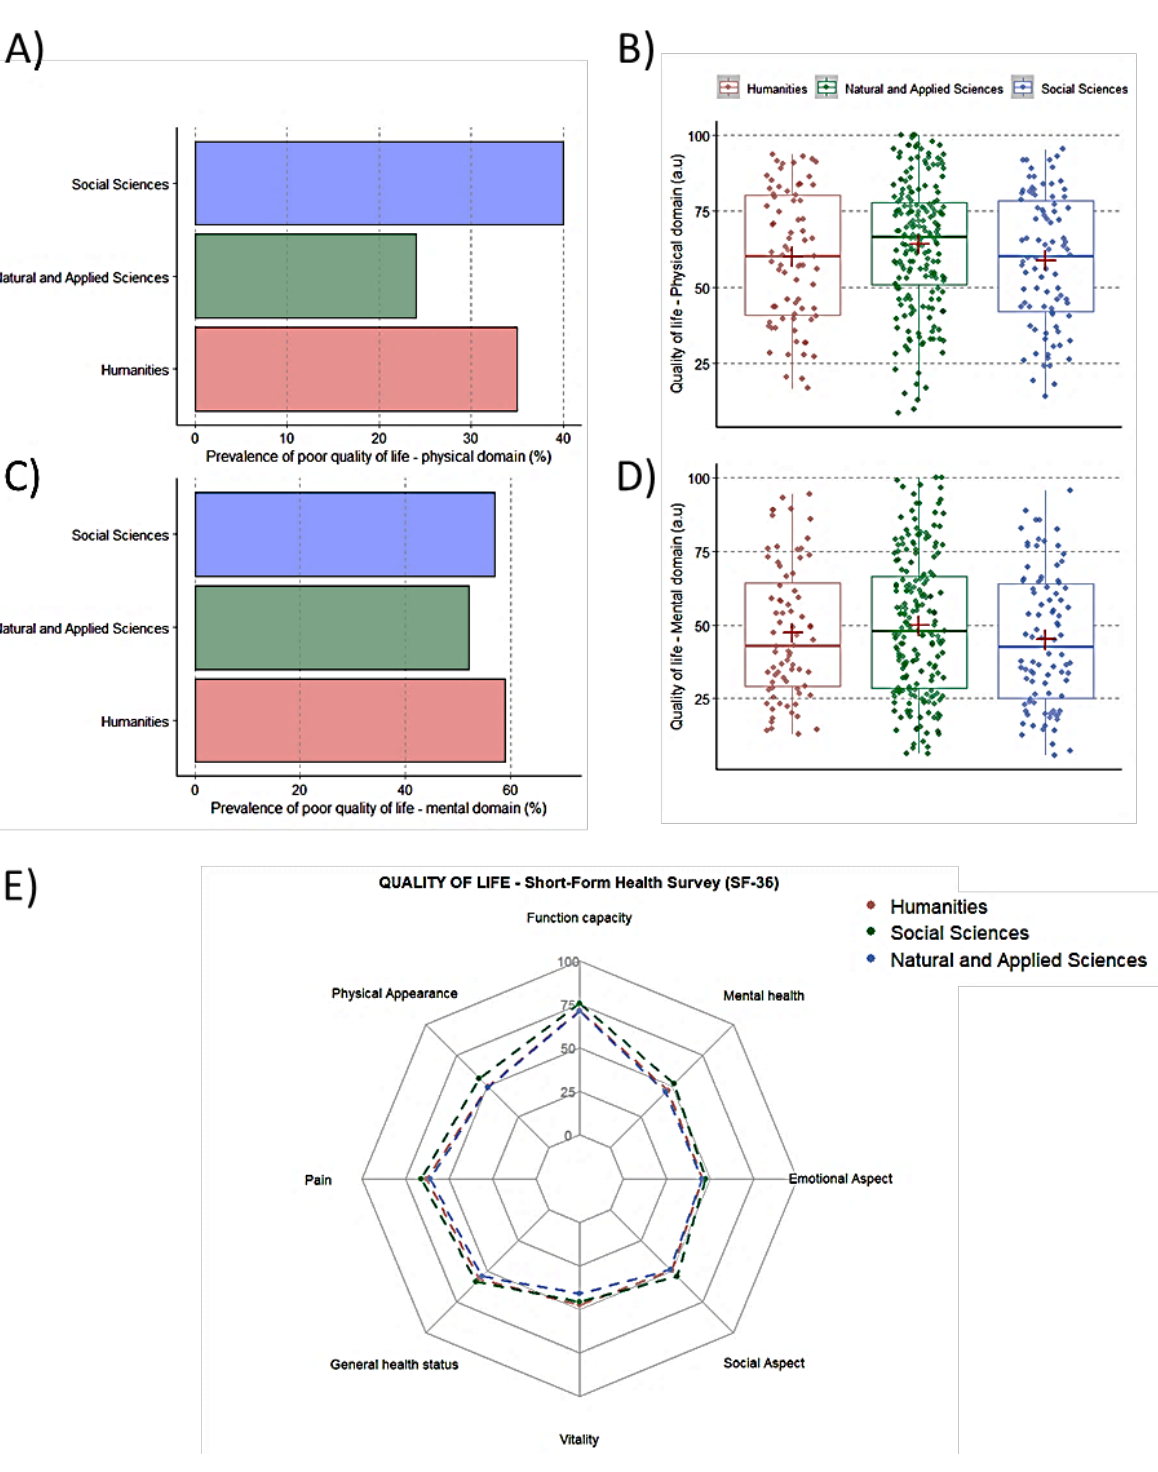
Figure 4. Scores of quality of life according to academic areas. Panel ( A ): Prevalence of poor quality of life in the physical domain (Score < 50); Panel ( B ): Scores of quality of life in the physical domain; Panel ( C ): Prevalence of poor quality of life in the mental domain (Score < 50); Panel ( D ). Scores of quality of life in the mental domain; Panel ( E ): Radar plot of quality of life in each domain.